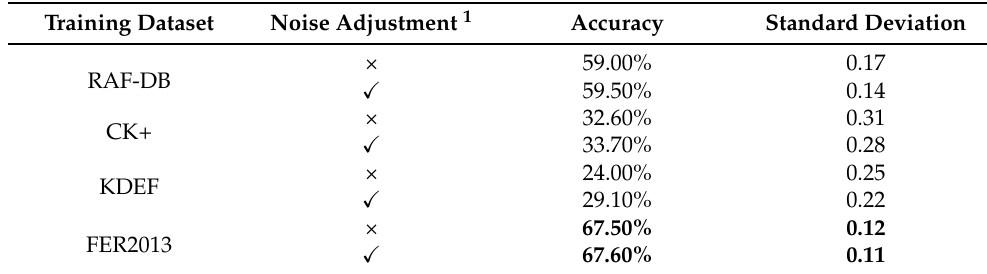
Table 5. Effect of models in Experiment 2.